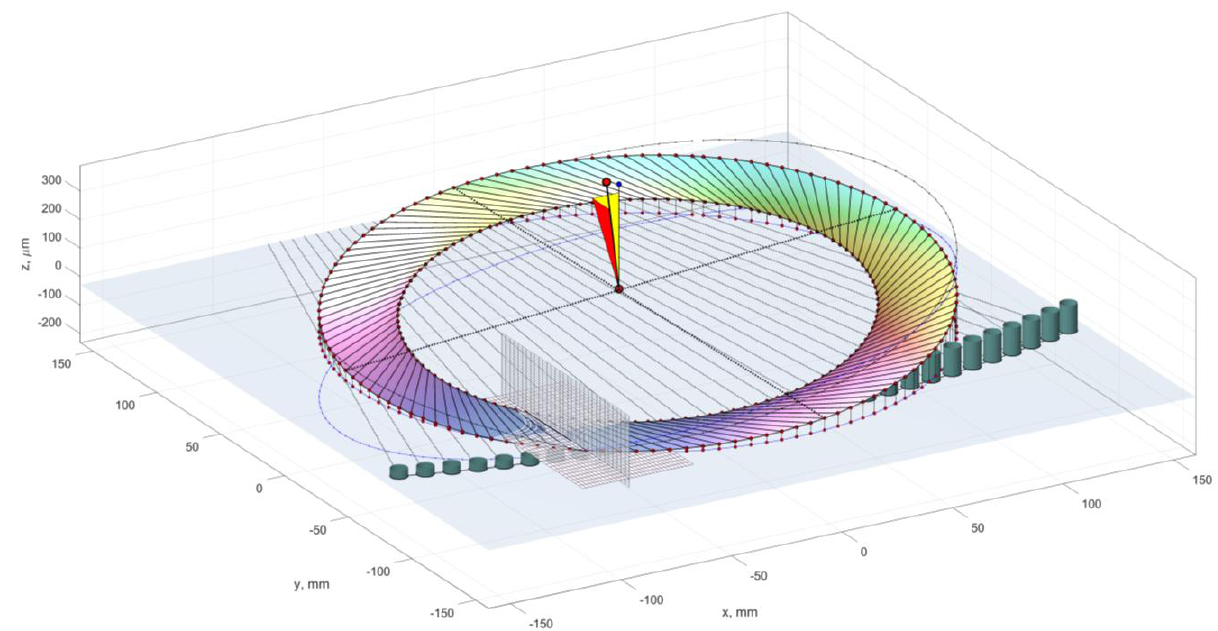
Figure 11. Grinding method for small ceramic parts.